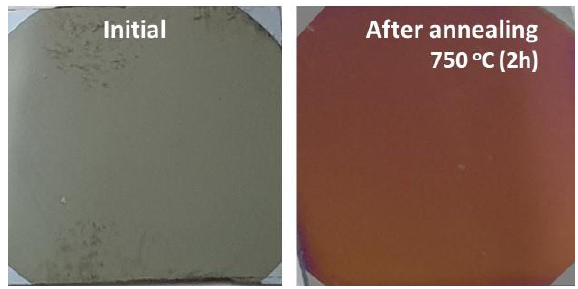
Figure 1. Photos of the CoNiAl samples before and after